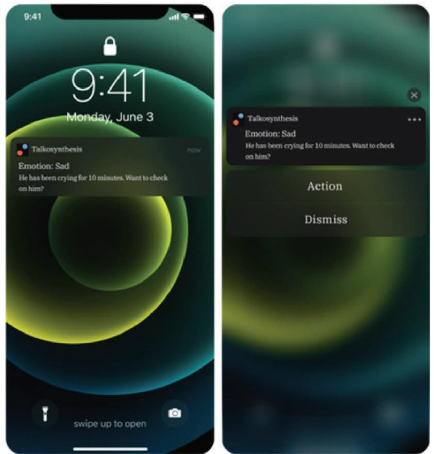
Figure 9: Screens showing the